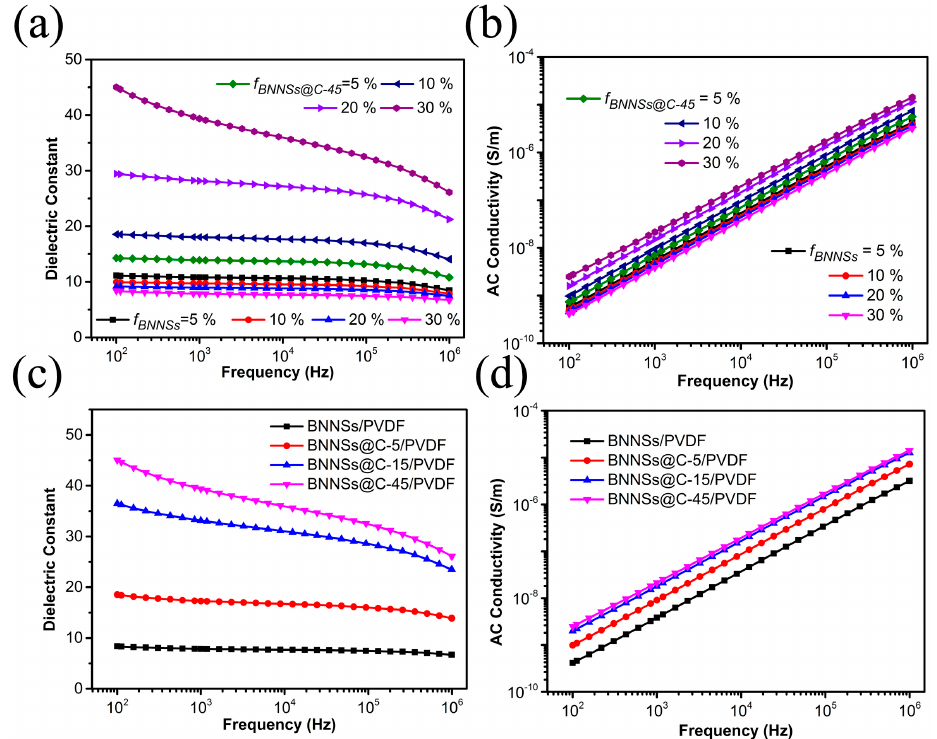
Figure 5. Frequency dependence of the ( a ) dielectric constant and ( b ) ac conductivity values of BNNSs/PVDF and BNNSs@C-45/PVDF nanocomposites at different filler loadings; Typical frequency-dependent comparison of ( c ) dielectric constant and ( d ) ac conductivity values of BNNSs/PVDF, BNNSs@C-5/PVDF, BNNSs@C-15/PVDF, and BNNSs@C-45/PVDF nanocomposites at equivalent filler loadings (30 vol %).